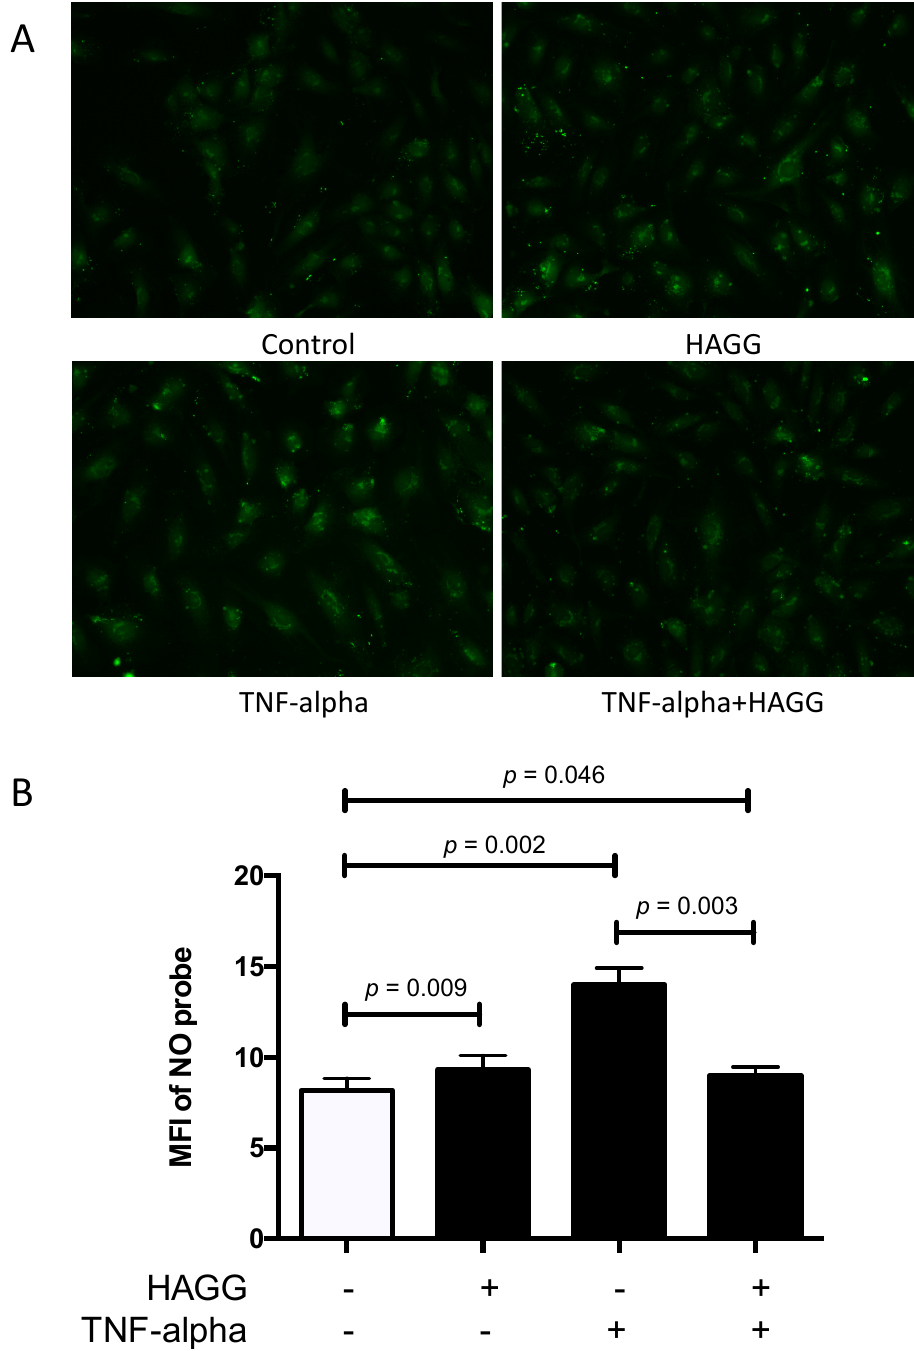
Figure 5. HAGG induced intracellular nitric oxide (NO) production in GECs. GECs were cultured with complete medium (Control), HAGG (400 µ g / mL), TNF- α (10 ng / mL), or TNF- α plus HAGG, for 24